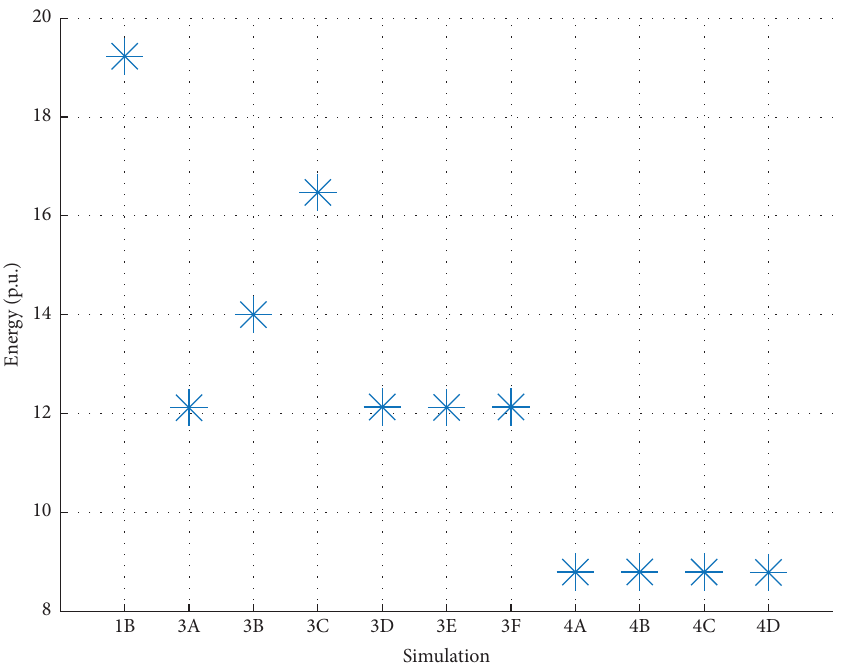
Figure 10: Energy delivered by diesel generators in every